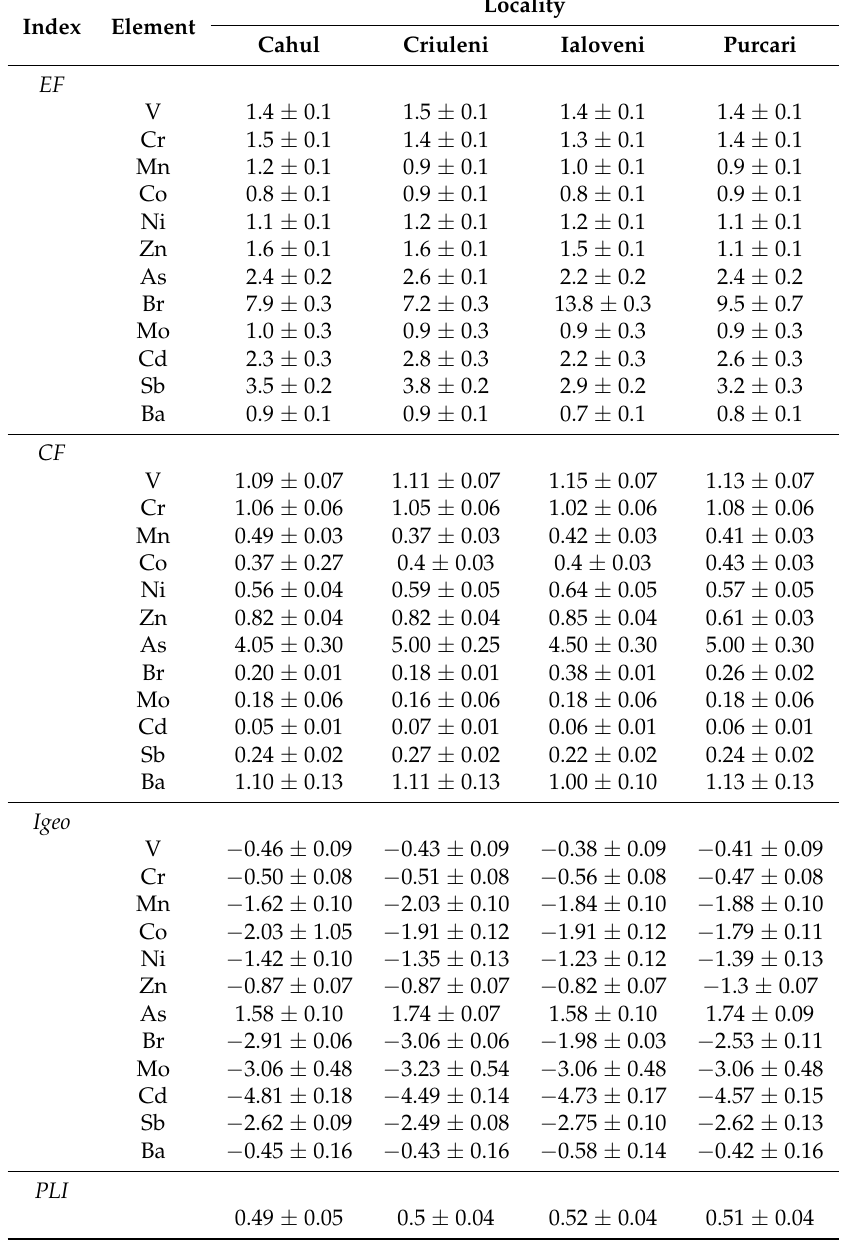
Table A3. The experimental values of the Enrichment Factor ( EF ) [29], Contamination Factor ( CF ) [30], Geo-accumulation Index ( Igeo ) [31], as well as the Pollution Load Index ( PLI ) [32] for elements considered as potentially hazardous according to national regulations